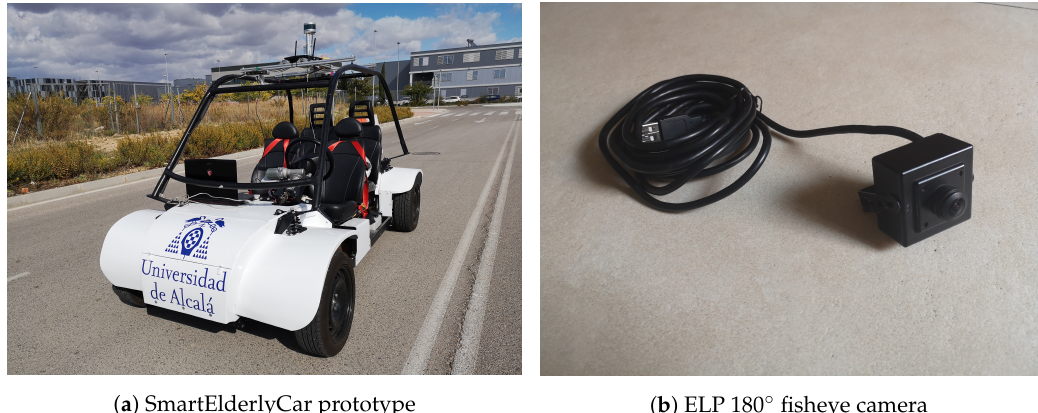
Figure 11. Autonomous open-source electric car and fisheye camera.